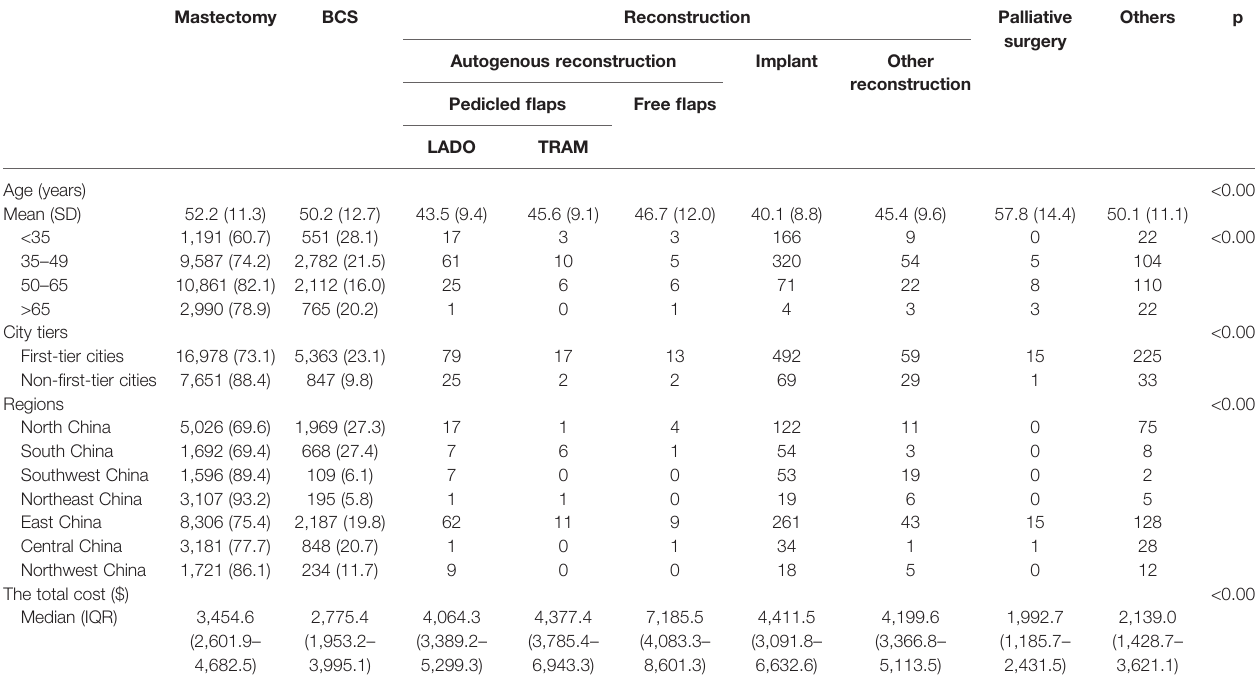
TABLE 3 | Breast surgery distribution of age, city tiers, regions, and the total cost. Mastectomy BCS Reconstruction Palliative Autogenous reconstruction Implant Other